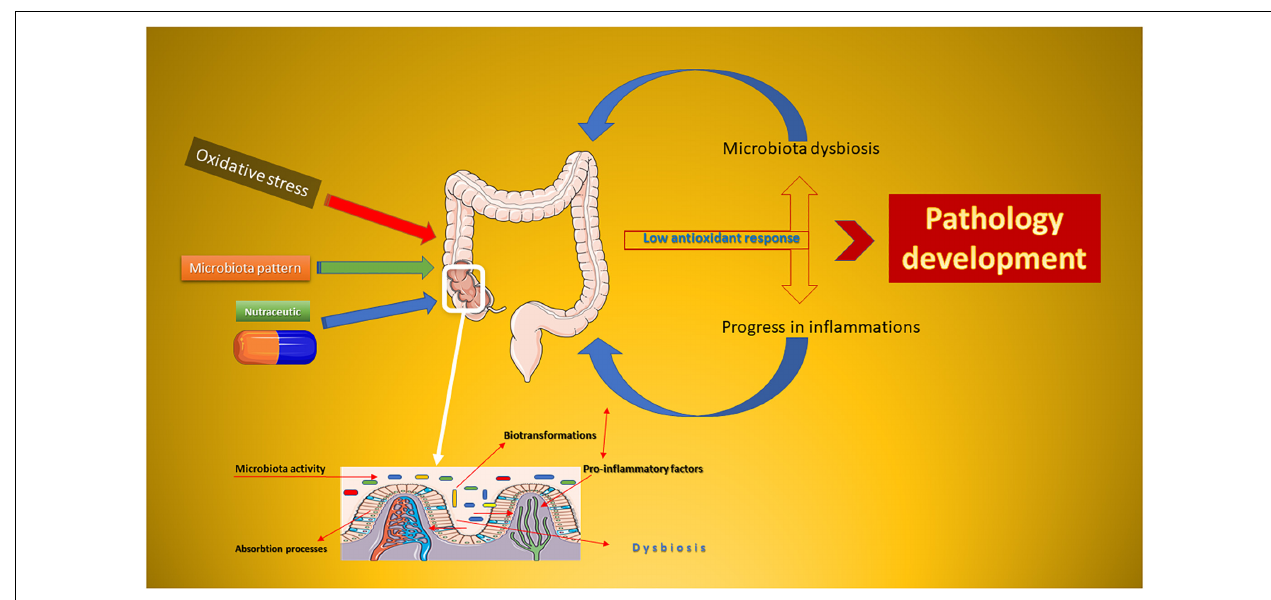
FIGURE 1 | Schematic representation of the oxidative stress-dysbiosis-pathology progression. This Figure was obtained in part by using images from Servier Medical Art, licensed under CC-BY 3.0.CC BY 3.0.